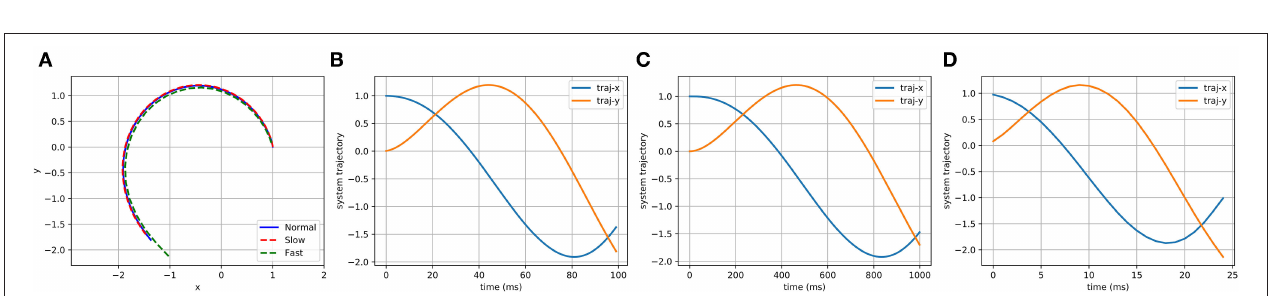
FIGURE 4 | The temporal scaling feature of DMPs. In (A) , we can see that DMPs have planned three different trajectory speeds labeled as “Normal,” “Slow,” and “Fast,” which are shown in (B–D) . When comparing (B–D) , it is evident that the trajectories of the x-axis and y-axis are same, but the time to finish the path is different.